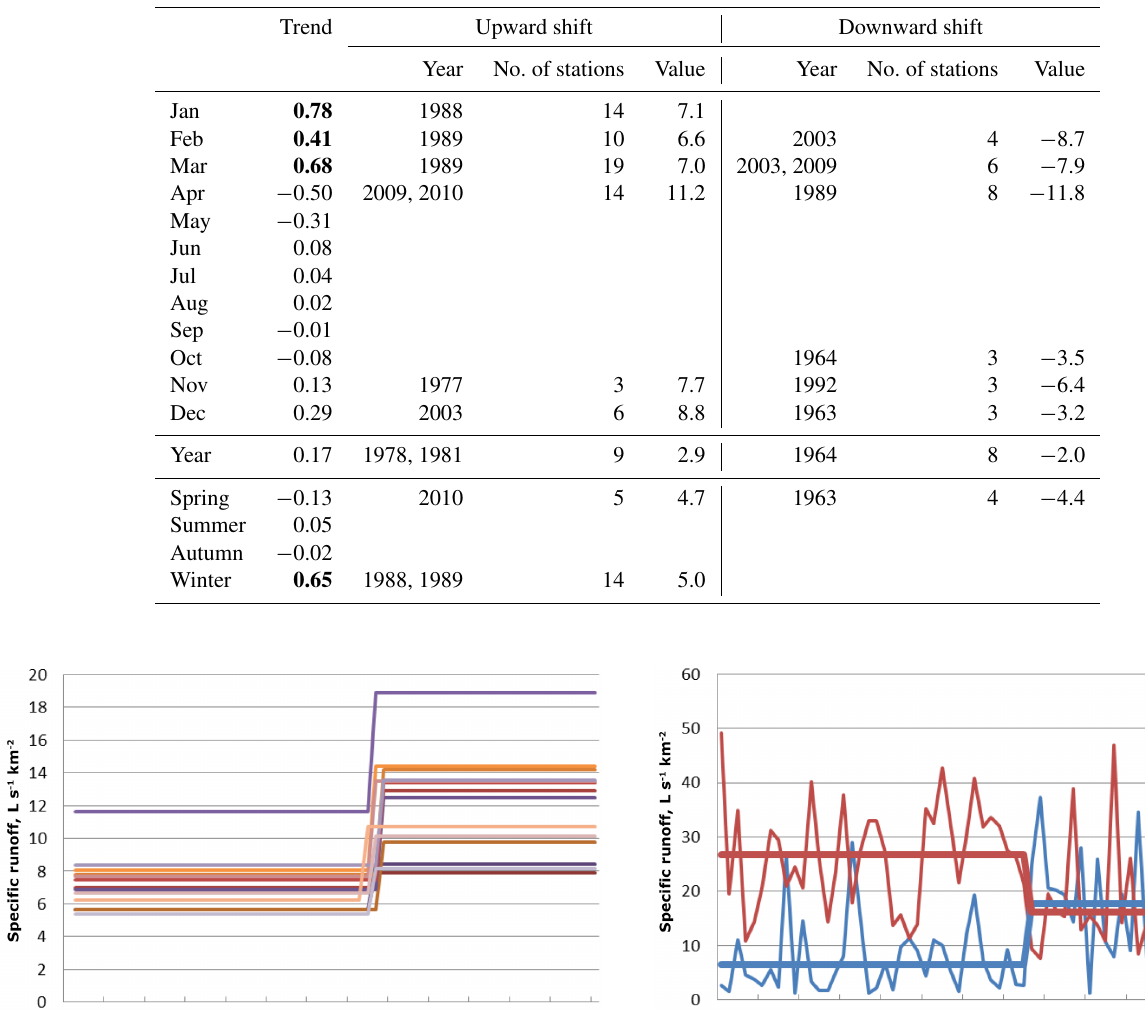
Table 7. Trend values of mean monthly, annual and seasonal specific runoff averaged over the 21 stations in Estonia. Statistically significant trends at the p <0.05 level are in bold. Shift years, mean shift values and numbers of stations with statistically significant regime shifts in specific runoff.